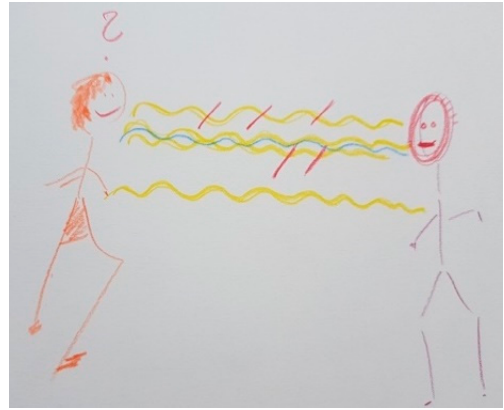
Figure 2. FC6’s perception of PD.